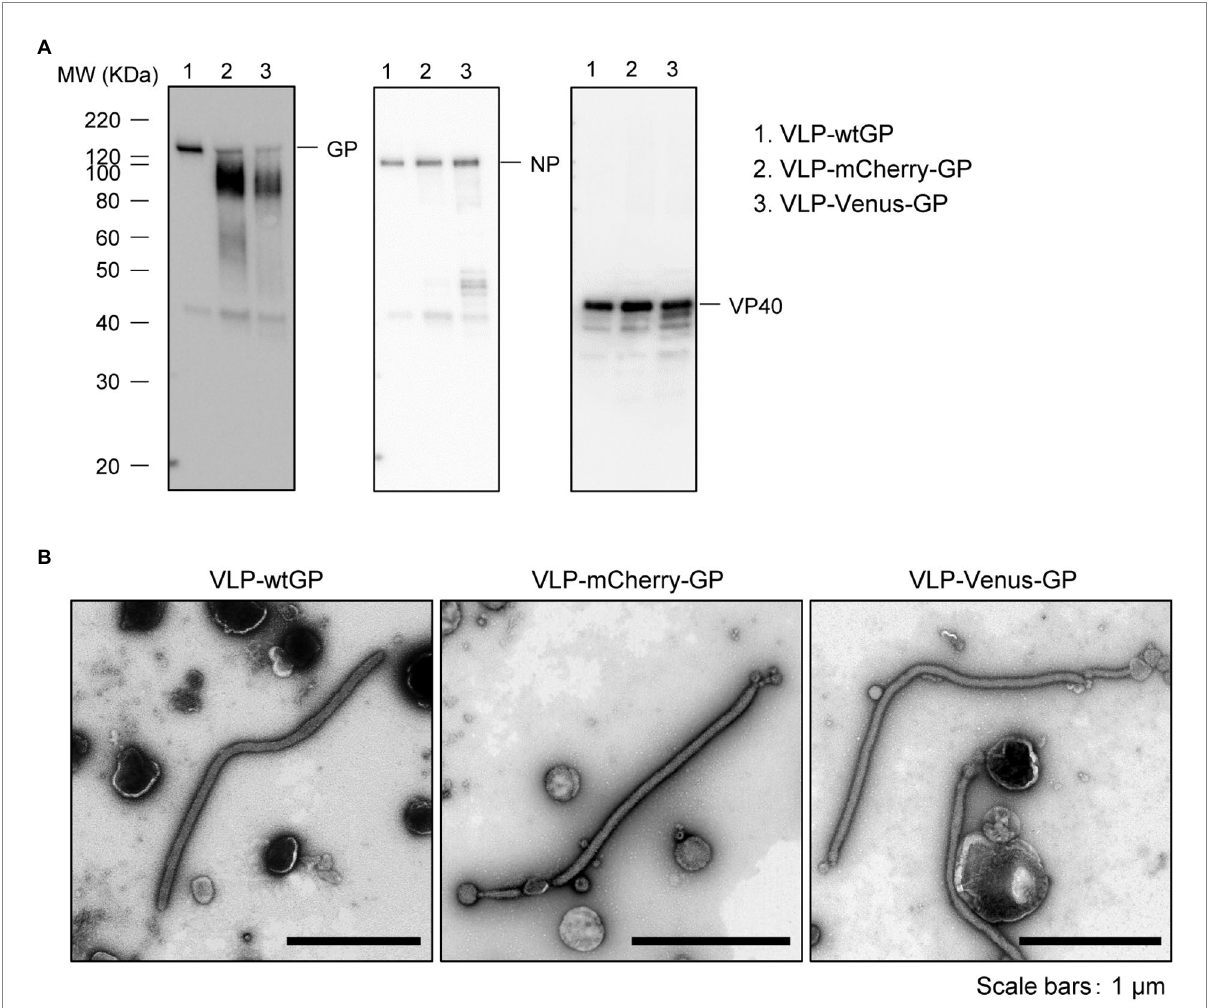
FIGURE 2 Morphological properties of Ebola VLPs containing fluorescent protein-fused GPs. (A) Validation of incorporation of fluorescent protein-fused GPs into viral particles. Expi293F cells were transfected with the expression plasmids for wt and two GP derivatives, NP and VP40. Ebola VLPs released into culture supernatants were purified by ultracentrifugation and expression of GP (left), NP (middle), and VP40 (right) in purified VLPs was analyzed by western blot analysis. (B) Analysis of morphological features of VLPs containing fluorescent protein-fused GPs. Purified VLPs spiked with wtGP (left), mCherry-GP (middle) and Venus-GP (right) were analyzed by negative staining with electron microscopy. Scale bars: 1 μ